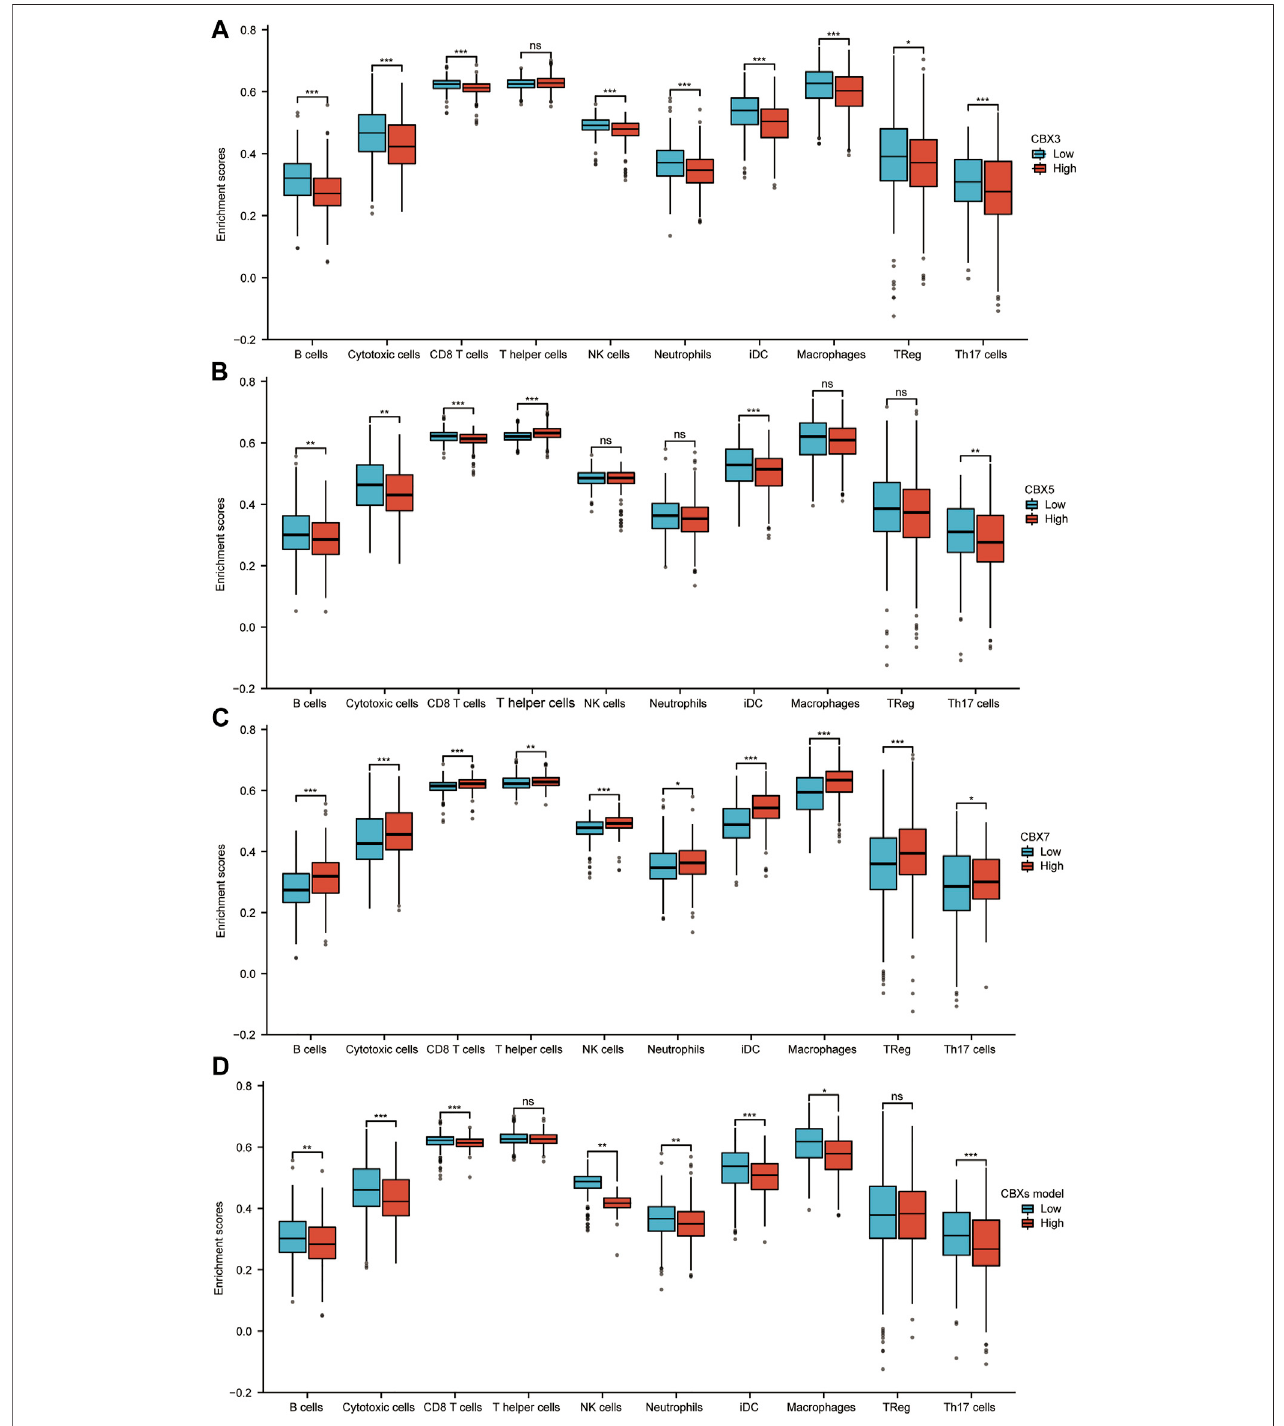
FIGURE7| Correlationanalysis ofCBX3/5/7 expression and in fi ltration levels ofimmune cells inLUAD tissues. (A – D) Boxplotsofthe correlations betweenCBX3/ 5/7 or molecular model expression and in fi ltration levels of immune cells. * p < 0.05, ** p < 0.01, *** p < 0.001.